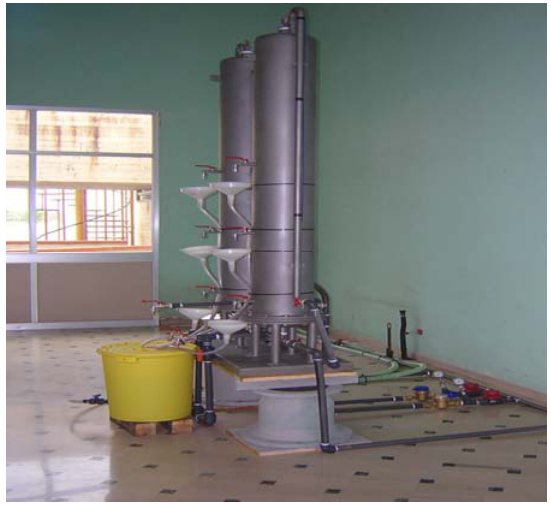
Fig. 1b. Fortore GAC pilot